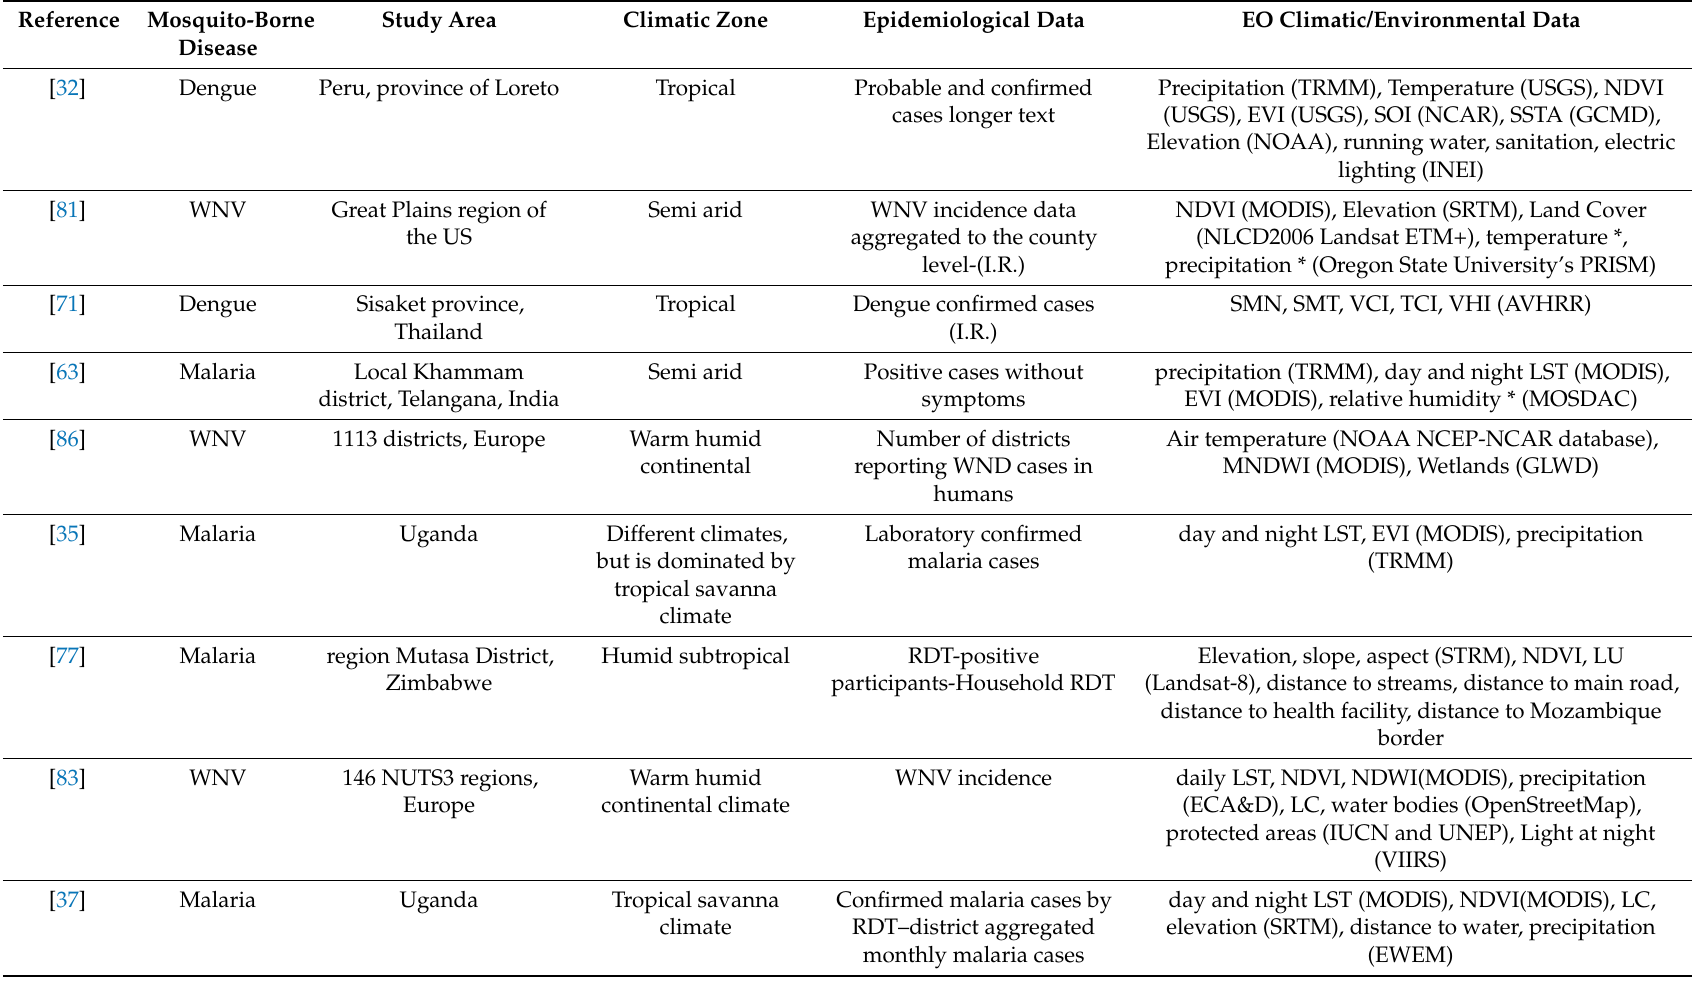
Table A4. Overview of studies that utilized EO derived environmental/climatic variables and epidemiological data * in situ